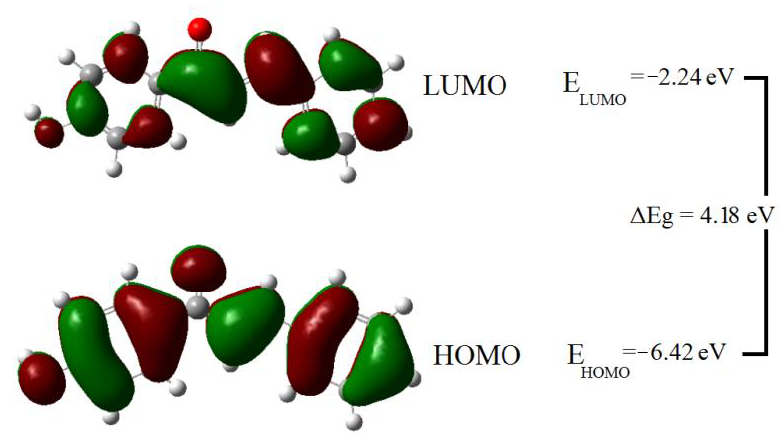
Figure 4. Surface plots showing the studied molecule’s frontier molecular orbitals.